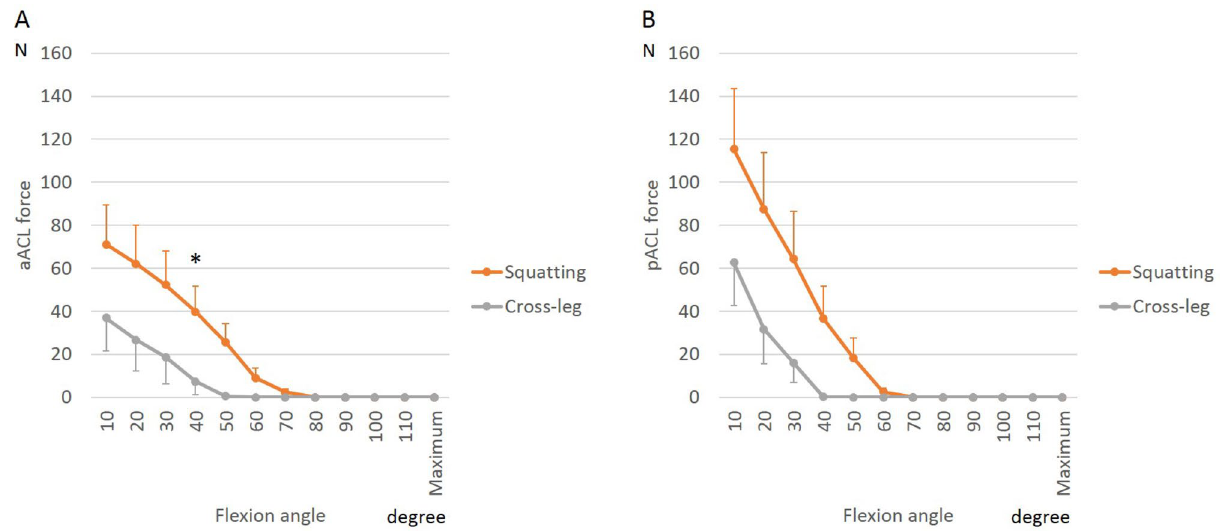
Figure 6. Anterior cruciate ligament (ACL) force during postoperative activities in bicruciate-retaining total knee arthroplasty: ( A ) Anteromedial bundle of the ACL (aACL); ( B ) Posterolateral bundle of the ACL (pACL). *A significant difference between knees during squatting and knees during cross-legged sitting ( p ≤ 0.05).